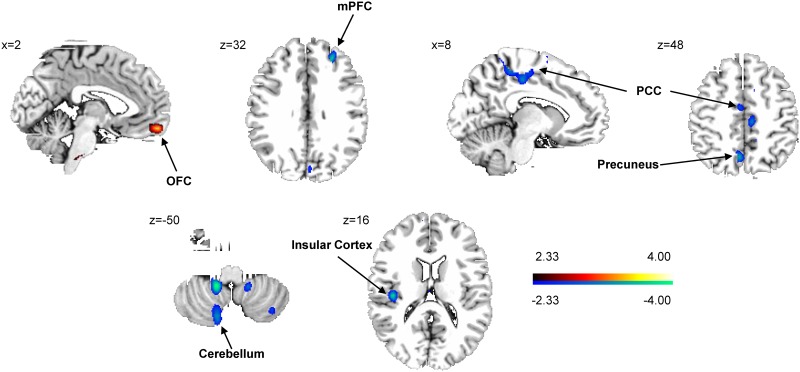
Motor learning-related spatial covariance pattern in subjects with presymptomatic Huntington’s disease.This pattern was characterized by increasing activity in the right orbitofrontal cortex (OFC; BA11) and concurrent relative decreases in the right medial prefrontal cortex (mPFC; BA10), left insular cortex (BA20), left precuneus (BA7), left cerebellum and the right posterior cingulate cortex (PCC; BA31). [The “red” blob indicates increasing activity, “blue” blobs show decreasing activity. The colored bar displays the z-score range; coordinates are displayed in MNI standard space.]